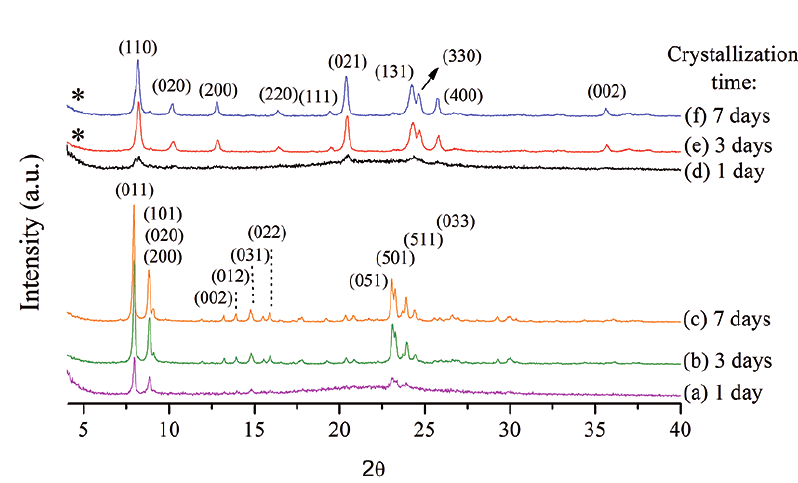
Figure 9: X-ray diffractograms of the samples synthesized using the method B with reaction times of (a) 1 day, (b) 3 days, (c) 7 days in static mode, and (d) 1 day, (e) 3 days, (f) 7 days with